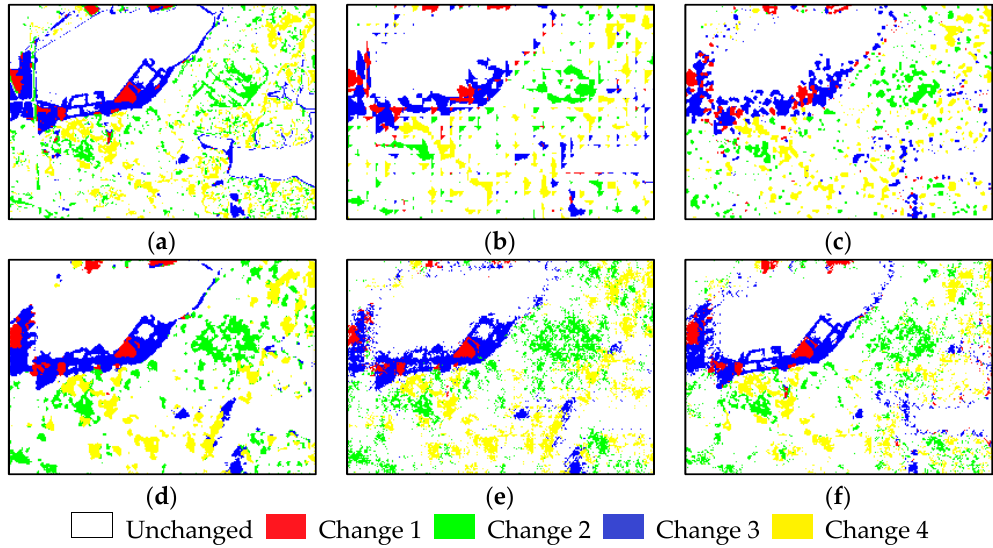
Figure 7. The SLCCD_DR results of the synthetic data set for the five SPM methods. ( a ) reference of the change map ( b ) bilinear interpolation-based model (BI) ( c ) pixel swapping algorithm (PSA) ( d ) the hopfield neural network (HNN) ( e ) comparison of SPM result based on BPNN (BPNN_SPM) ( f ) BPNN with different resolution images (BPNN_DR).